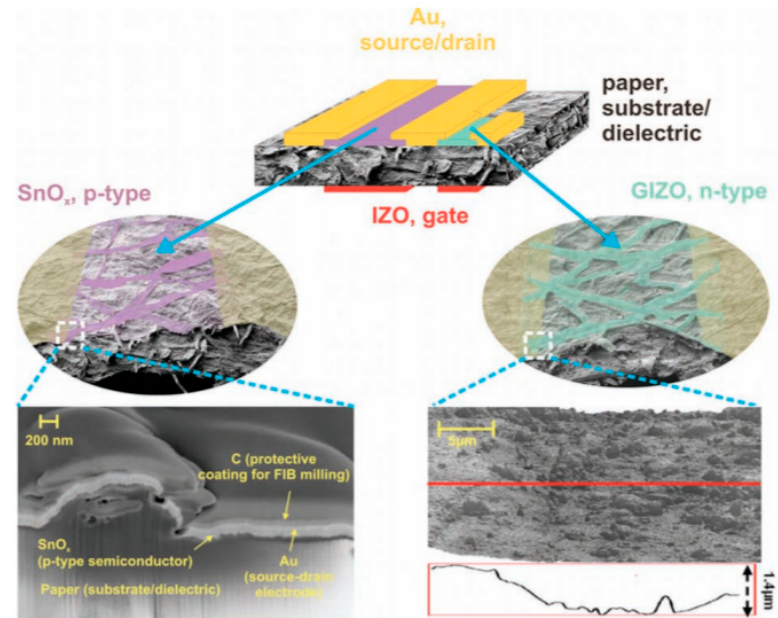
Figure 1. Device and paper substrate described by Martins et al. Source and drain of the two transistors composing the CMOS (Complementary Metal Oxide Semiconductor) inverter are deposited on top of a paper layer, while the indium-zinc oxide (IZO) bottom-gates are deposited on the other side. Drain and source electrodes are made of a Ni/Au film. The bottom-left figure shows a cross-sectional SEM image of a paper fiber from the p-type side, while the bottom-right figure shows an AFM (Atomic Force Microscopy) image of the section from the n-type side. Reproduced from [46] with permission. Copyright © 2012 Wiley and Sons.